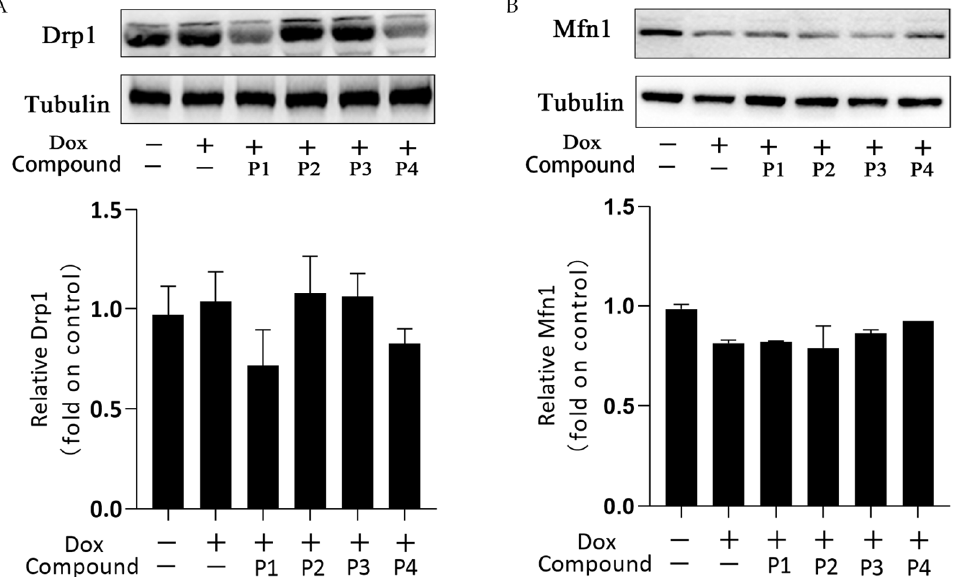
Figure 6. Effects of H. rhamnoides L. phenylpropanoids on mitochondrial dynamics–related proteins. ( A ) Expression and analysis of the mitochondrial division protein Drp1. ( B ) Expression and analysis of the mitochondrial fusion protein Mfn1.